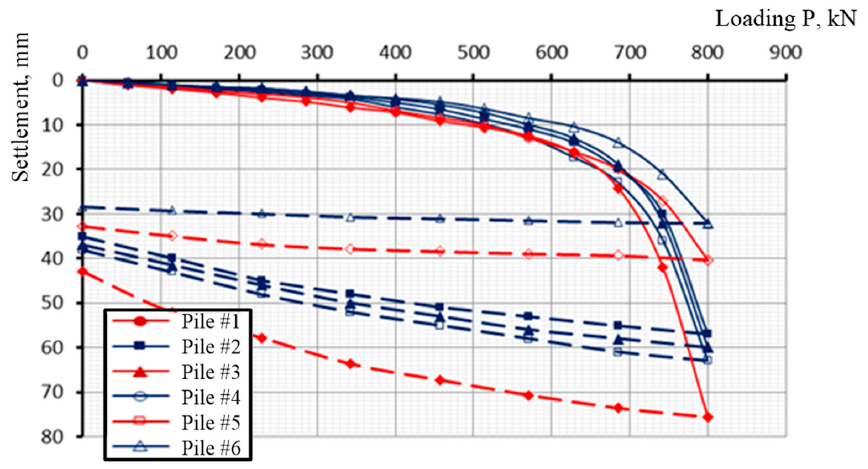
Figure 8. Correlation of loading P with settlement S according to the SLT results of the ordinary piles (without soil wetting).